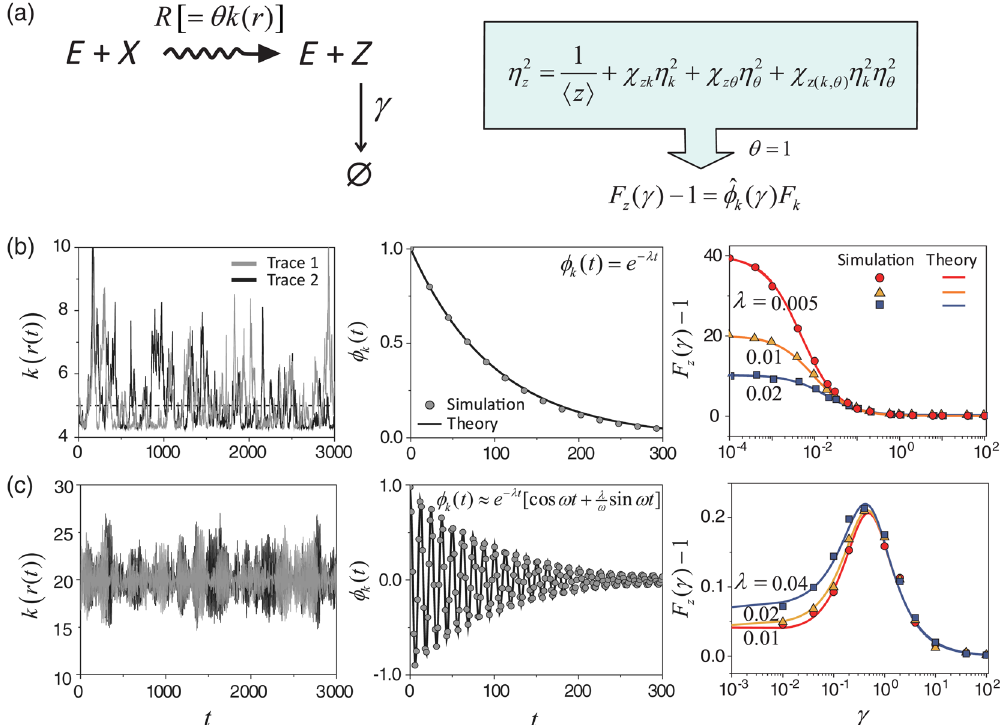
FIG. 2. Effects of environment-coupled fluctuations in the rate coefficient on the fluctuation in the product number. (a) Schematic representation of the vibrant reaction and ensuing decay of the product molecule with constant rate γ . The reaction rate R is factored into the reactant population-dependent rate factor θ and the rate coefficient k , which are dependent on environmental variable r . η 2 ≡ h δ z 2 i = h z i 2 Þ is given by Eq. (2). (b),(c) Comparison between the prediction of Eq. (2) for Fano factor F η 2 z iÞ and stochastic z ð¼ z ð z h simulation results on two different models of environment-coupled reaction. We focus on the situation where the fluctuation in the − 1 is proportional to reaction rate R is dominated by the fluctuation in the rate coefficient k by setting θ equal to unity. F R z ∞ − γ t ϕ δ k 2 i = h k iÞ with the proportionality coefficient given by ˆ ϕ γ Þ ¼ F t Þ with ϕ t Þ being the normalized time-correlation 0 dte k ð¼ h k ð k ð k ð function of rate-coefficient fluctuation [Eq. (C1)]. Examples of stochastic time trace of k , which is a function of stochastic variable r ð t Þ γ Þ − 1 (right-hand panel), are displayed for the following models. (b) k ð r Þ ¼ k κ r 2 t Þ (middle panel), and F (left-hand panel), ϕ 0 þ k ð z ð with stochastic dynamics of r being the stationary Gaussian Markov process known as Ornstein-Uhlenbeck process [46]. λ stands for the is a monotonically decaying function of γ . relaxation rate of the fluctuation in r defined by h r ð t Þ r ð 0 Þi ¼ h r 2 i e − λ t= 2 . F z (c) k ð r Þ ¼ κ exp ½ − β r (cid:2) with stochastic dynamics of r being the stationary Gaussian non-Markov process describing the position of the weakly damped harmonic oscillator with mass m under the frictional force 2 m λ dr ð t Þ =dt [47]. For this model, h r ð t Þ r ð 0 Þi is given by t Þ is an oscillatory , where ω 0 is the natural frequency of the oscillator. When ϕ k ð − 1 can be a nonmonotonic function of γ . See Appendix C for the details of the function, F z